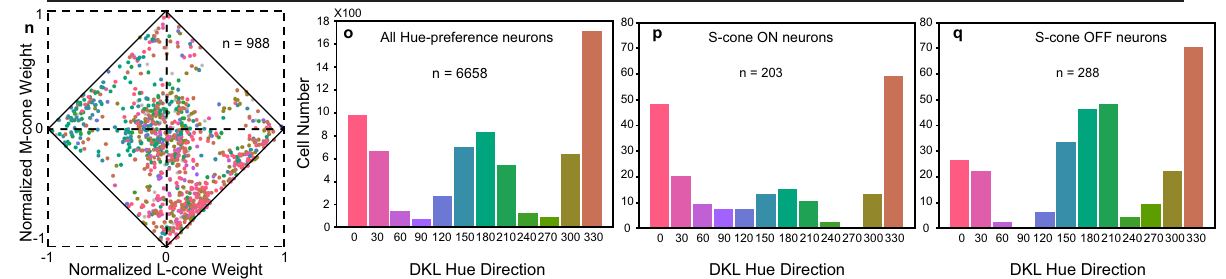
Fig. 5 | DKL hue map and its relationships to COFDs and Cone weights. a Schematicof stimuluspresentation. b – e ISIhue-phasemapsinresponseto4hue directions(animalA2).Scalebarin b :1mm;appliesto b – e .(SD:standarddeviation of pixel distributions). f DKL hue preference map from same imaging region as Fig.3f – i. Individualneurons aredepictedbased ontheirpreferredDKLhue or gray (not hue selective). Color key indicates the relationship between the hues for plotting themap(outerring)andhuesused forstimulation(innerdisk). g DKLhue preference map (from f ) overlaid on DKL hue polar map from ISI. h , i DKL hue preference map (from f ) overlaid on M-cone and S-cone COFDs (from Fig. 3g, h). Scalebarin g :200 µ m;appliesto f – i . j Autocorrelationofneuronalhuepreferences from f asafunctionofcorticaldistance.Blackdotsarefromactualdatashownin f ; gray dots are from the same data after shuf fl ing. k – m Relationships between ISI COFD organization and DKL hue preferences based on individual neurons